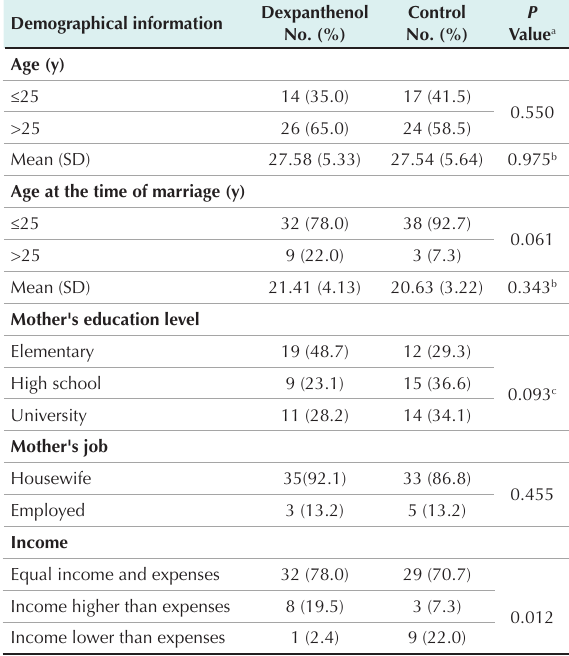
Table 1. Demographical Characteristics of Participants Demographical information